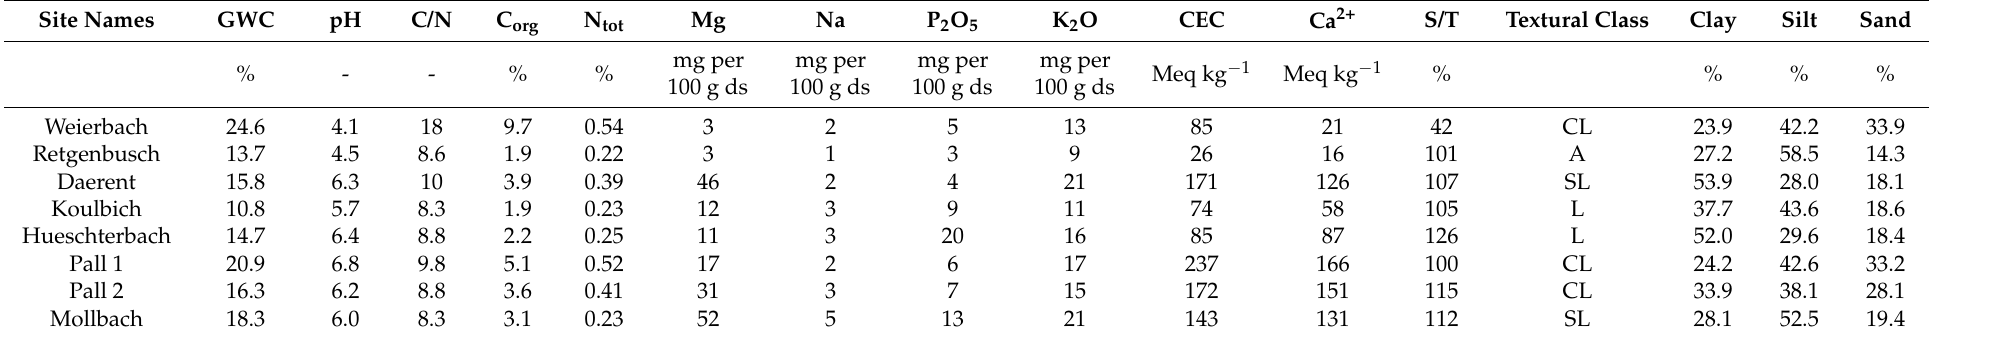
Table 2. Physical-chemical properties of the eight studied soils: GWC: gravimetric water content, C org : organic carbon, N tot : total nitrogen, CEC: cation exchangeable capacity, S/T: cation saturation rate, Ca 2+ : calcium